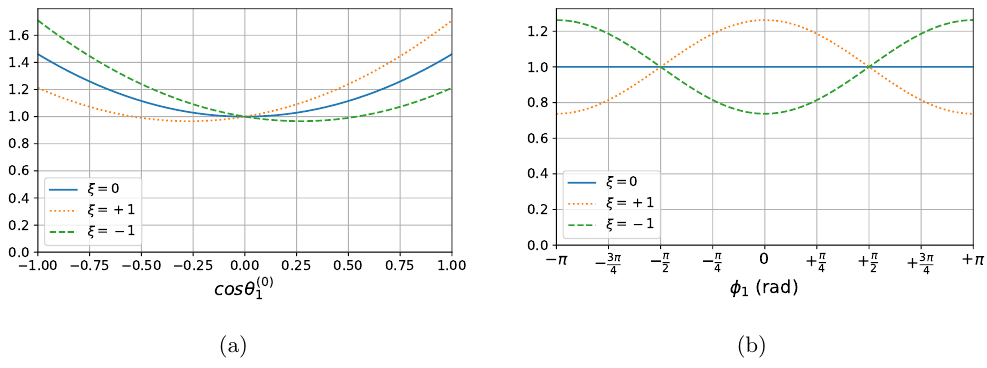
Figure 3 . Distributions in (a) the proton polar angle in the CM frame and (b) the proton azimuth angle in the (cid:3) frame for the e + e (cid:0) J= [(cid:3) p(cid:25) (cid:0) ](cid:22)(cid:3) process. Solid blue lines correspond to ! ! ! the unpolarized electron beam ( (cid:24) = 0), dotted orange lines correspond to the beam of electrons with double helicity (cid:24) = +1, and the dashed green lines correspond to the beam of electrons with double helicity (cid:24) = 1. (cid:0)